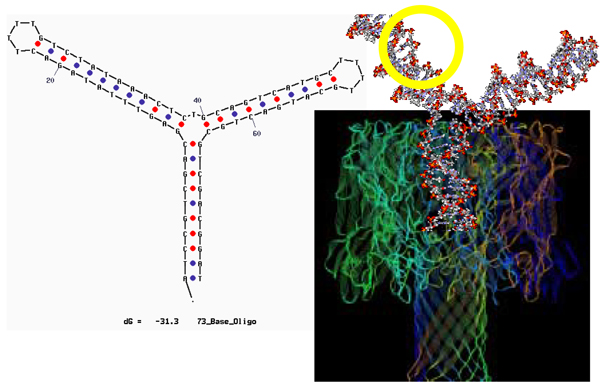
DNA Engineering: the goal is to design a bifunctional aptamer. Part of that bifunctionality hinges on a good reporter blockade (with stationary toggling). Such a blockade is partly brought about by having the Y-molecule caught at the mouth of the channel (such that the terminus of the dsDNA is over the limiting aperture). The other functionality is to bind to some target. The aptamer shown is designed to have a TATA box for TBP binding (the region indicated in the yellow circle).